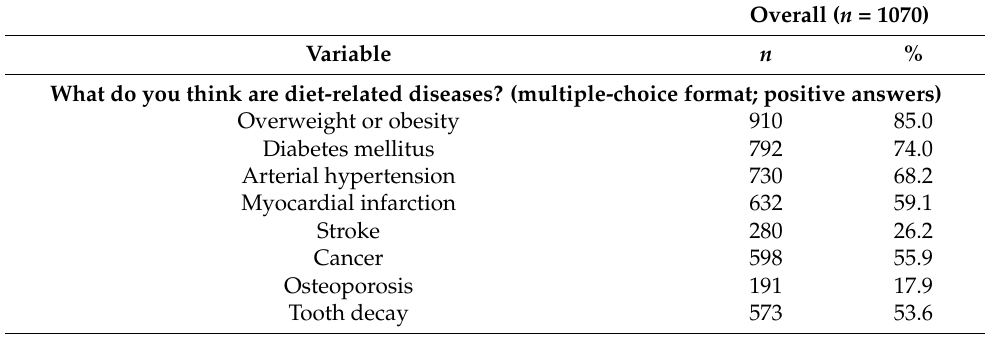
Table 2. Respondents’ knowledge regarding diet-related diseases and dietary risk factors ( n = 1070).